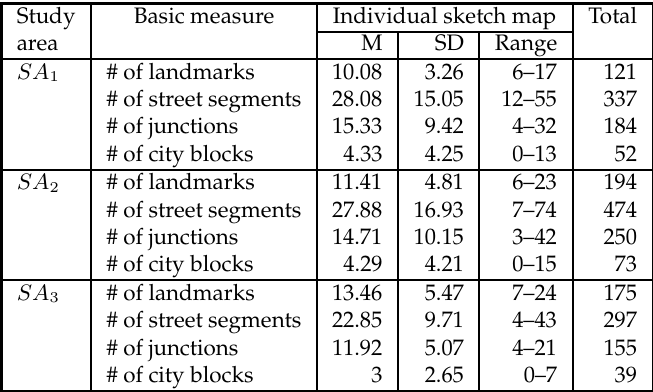
Table 4: Distribution of spatial objects in sketch maps.